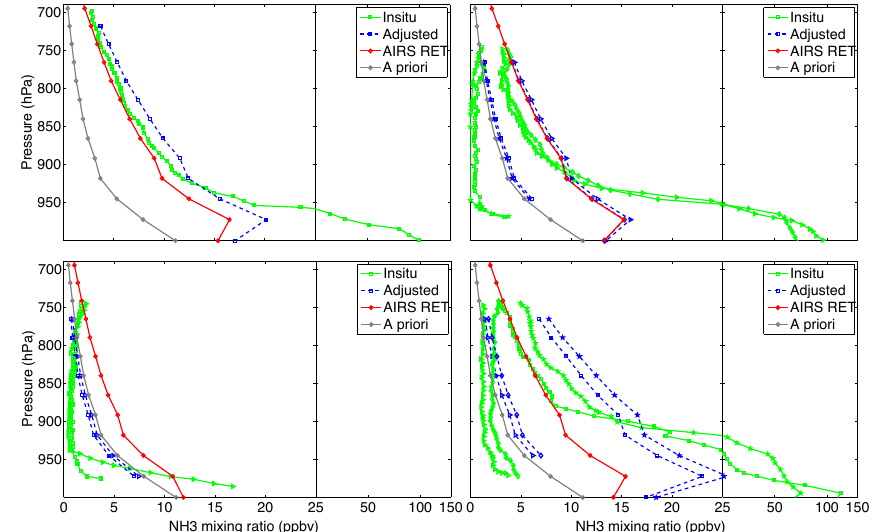
Figure 3. AIRS NH 3 validation against CRDS (the cavity ring down spectrometer) spiral profiles collected during the DISCOVER-AQ CA (16 January–6 February 2013). The red curves represent AIRS retrieved profiles, gray curves are the a priori profiles, green solid lines are in situ spiral profiles, and the blue dashed lines are the convolved profiles using AIRS NH 3 AKs. The x axis is linear from 0 to 25ppbv and logarithmic from 25 to